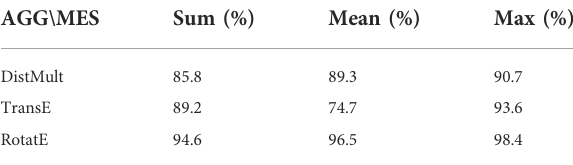
TABLE 2 AUROC results of different AGG and MES functions.